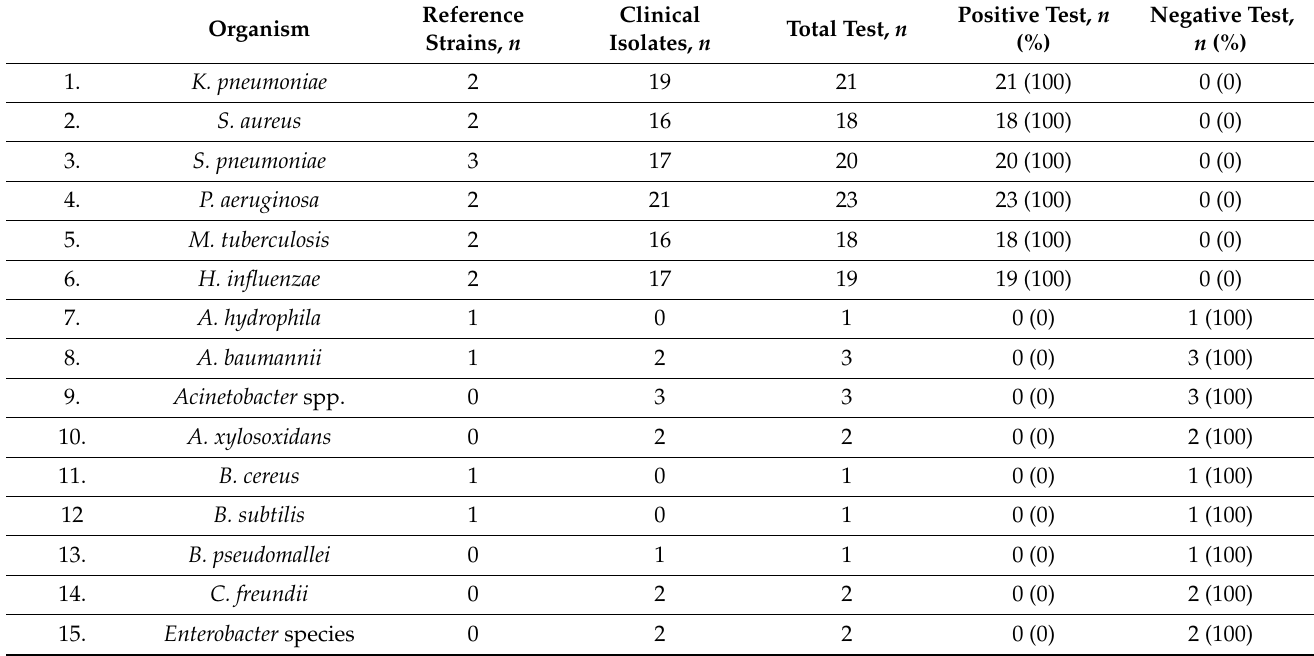
Table 2. Specificity evaluation of the single-tube heptaplex PCR assay using VITEK 2 identified clinical isolates ( n = 129). Reference Clinical Organism Total Test, Strains, n Isolates, n